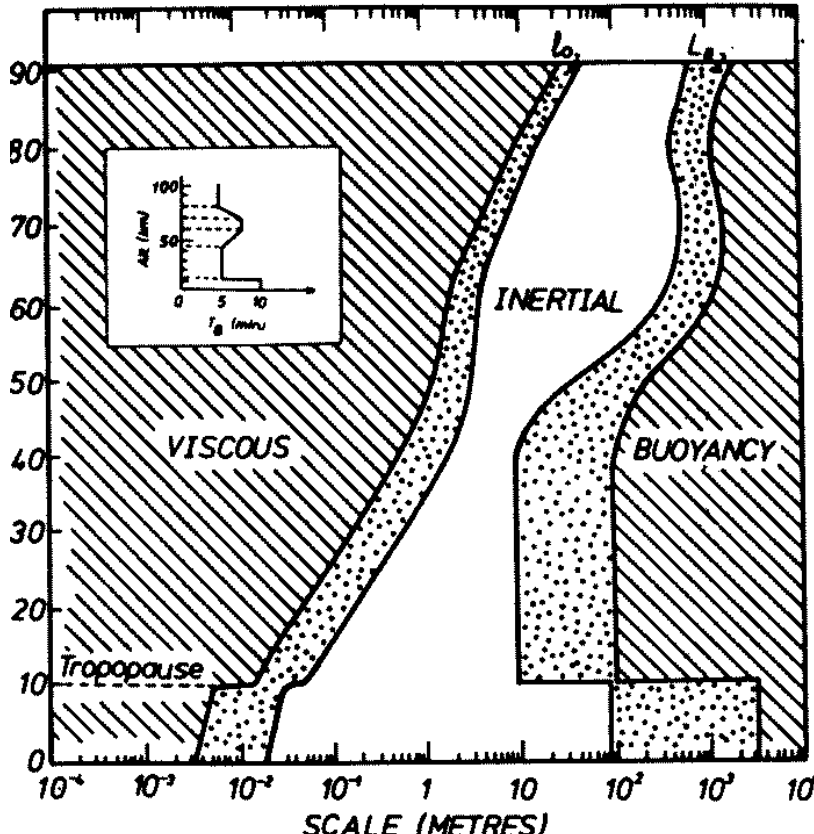
Fig. 2. Inner and outer scales of turbulence in the atmosphere (from Hocking,